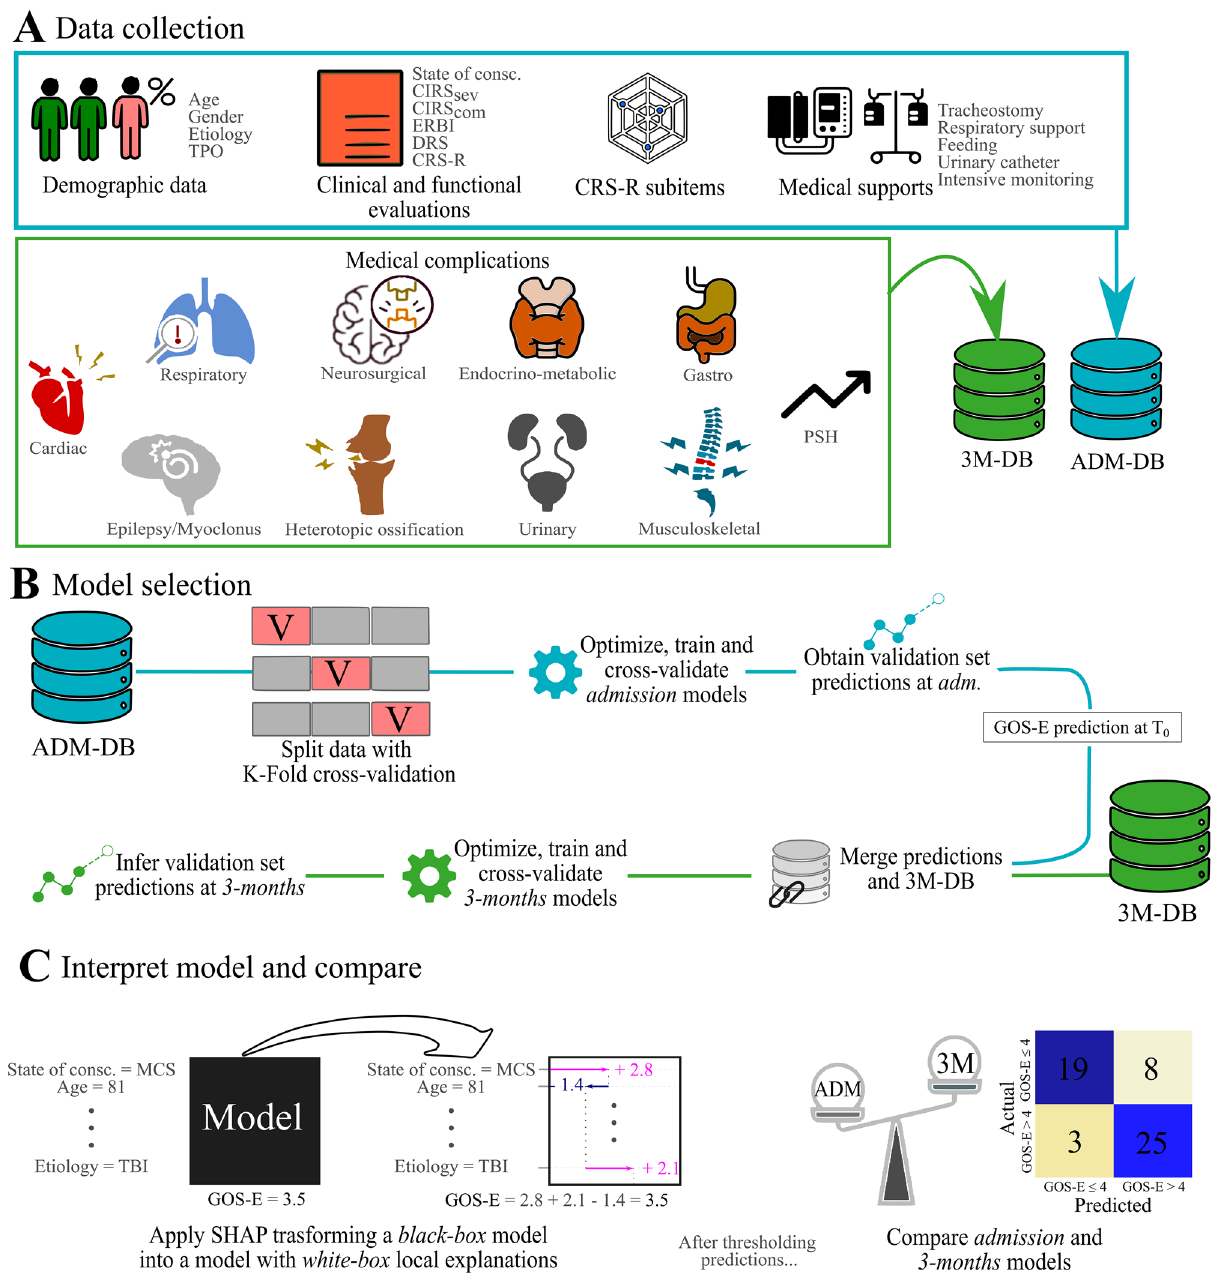
Figure 1. Work pipeline starting from data collection ( A ) at the admission (light blue, ADM-DB) and MCs at 3 months (green, 3M-DB). In the model selection, the k-fold cross-validated admission model predictions are attached, following the same k-fold split, to the MCs at 3 months ( B ). Together, these data are used to train and cross-validate the 3-month model. Both models have the GOS-E value at discharge as target. ( C ) Representative example of how weights assigned patient-wise to the independent variables contribute to the overall prediction (left) and how predictions are dichotomized for model comparison